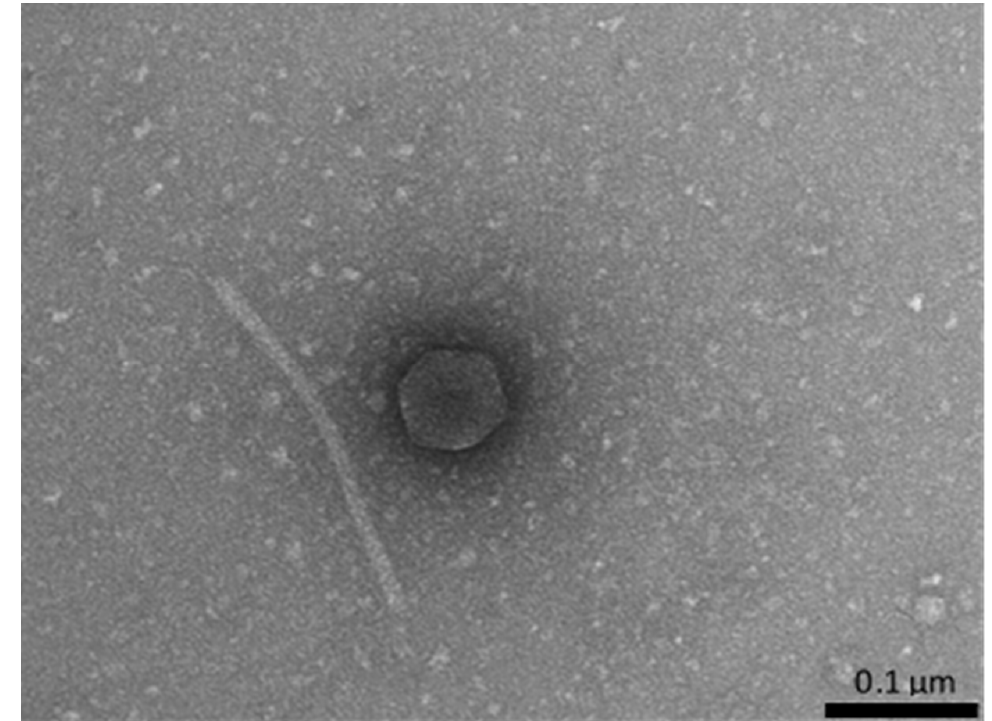
Figure 2. Electron micrograph of the virion of a bacteriophage isolated after induction of the Nocardia sp. strain JSZCL7 with 0.5 µ g/mL mitomycin C. Virions were very unstable under laboratory conditions, which is exemplified by disconnected head and tail of the virion.